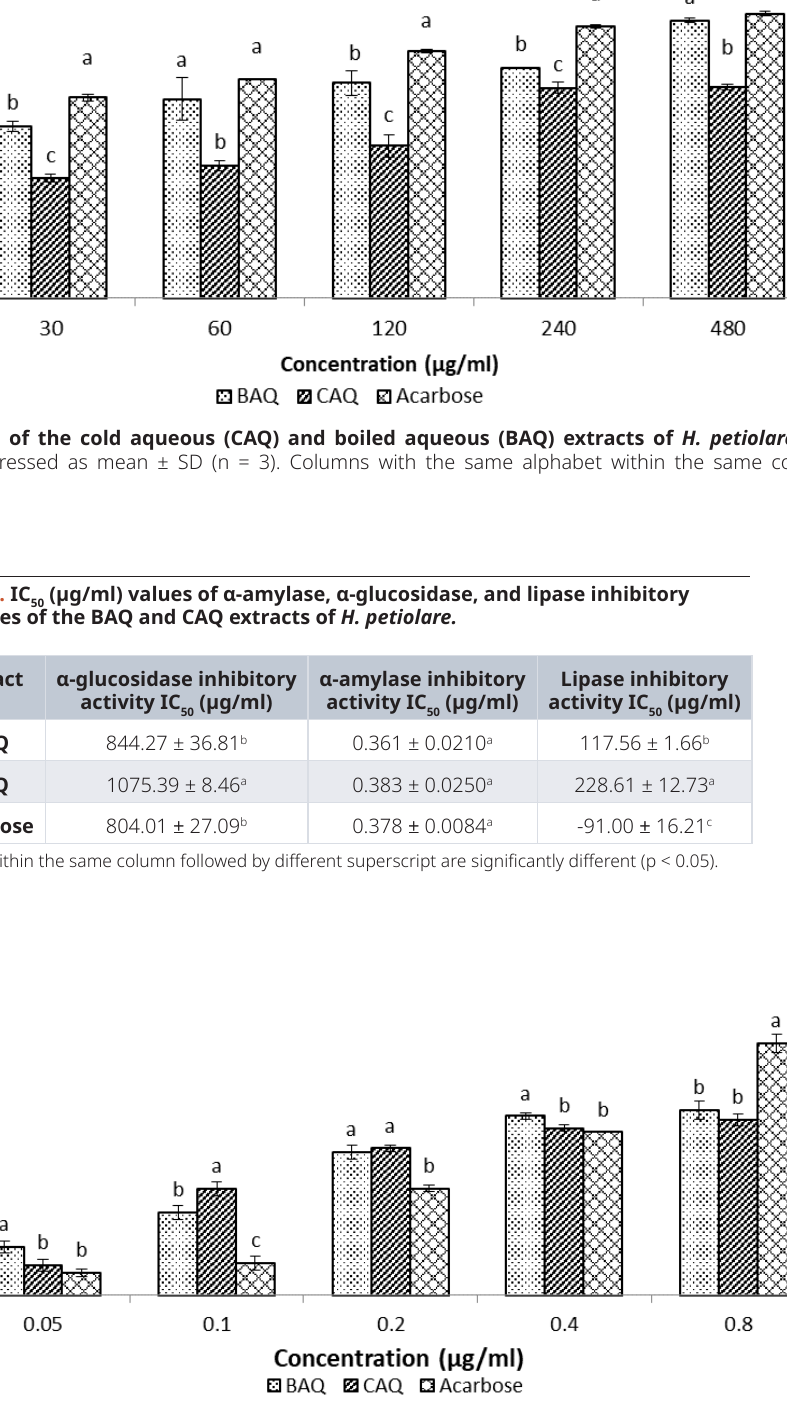
Figure 4. Inhibitory effects of the cold aqueous (CAQ) and boiled aqueous (BAQ) extracts of H. petiolare on α-amylase enzyme’s activity. Data expressed as mean ± SD (n = 3). Columns with the same alphabet within the same concentration are not significantly